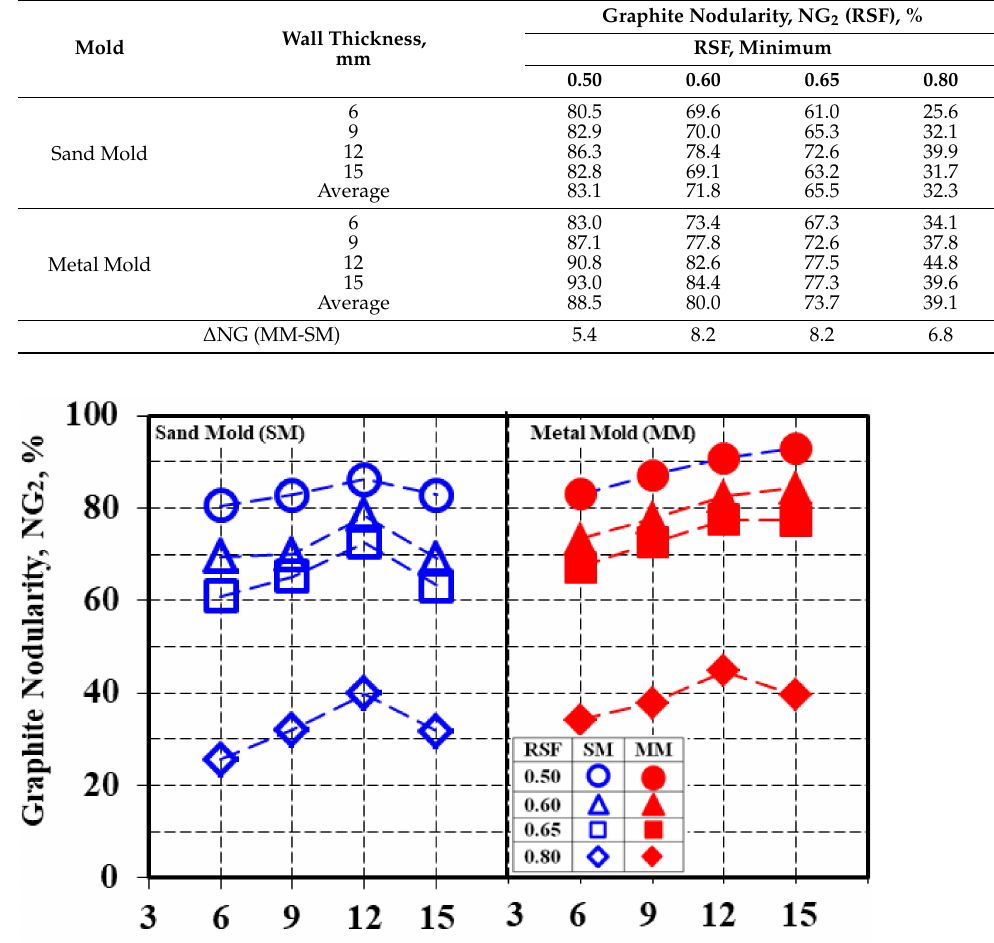
Table 4. Graphite nodularity (NG 2 ) at imposed minimum values for graphite roundness shape factor in